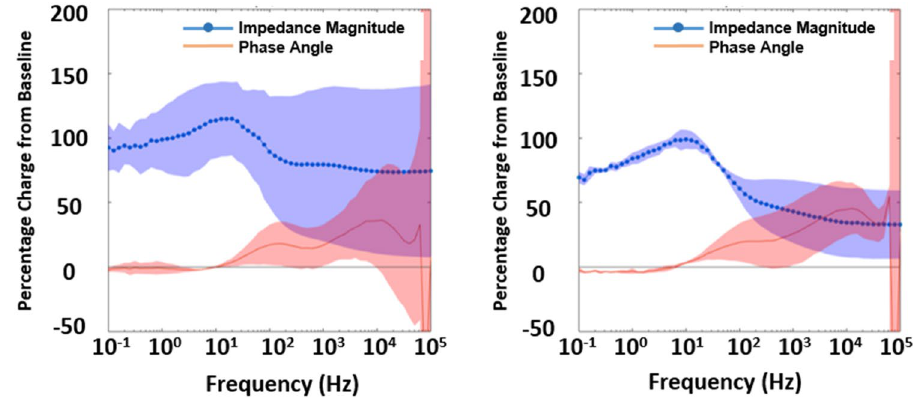
Fig. 4 Mean normalized impedance magnitude and phase angle measured from Si N samples, 20 h (left) and 3 4 36 h (right) after initial inocula- tion on substrate. N = 3. Shad- ing shows standard deviation